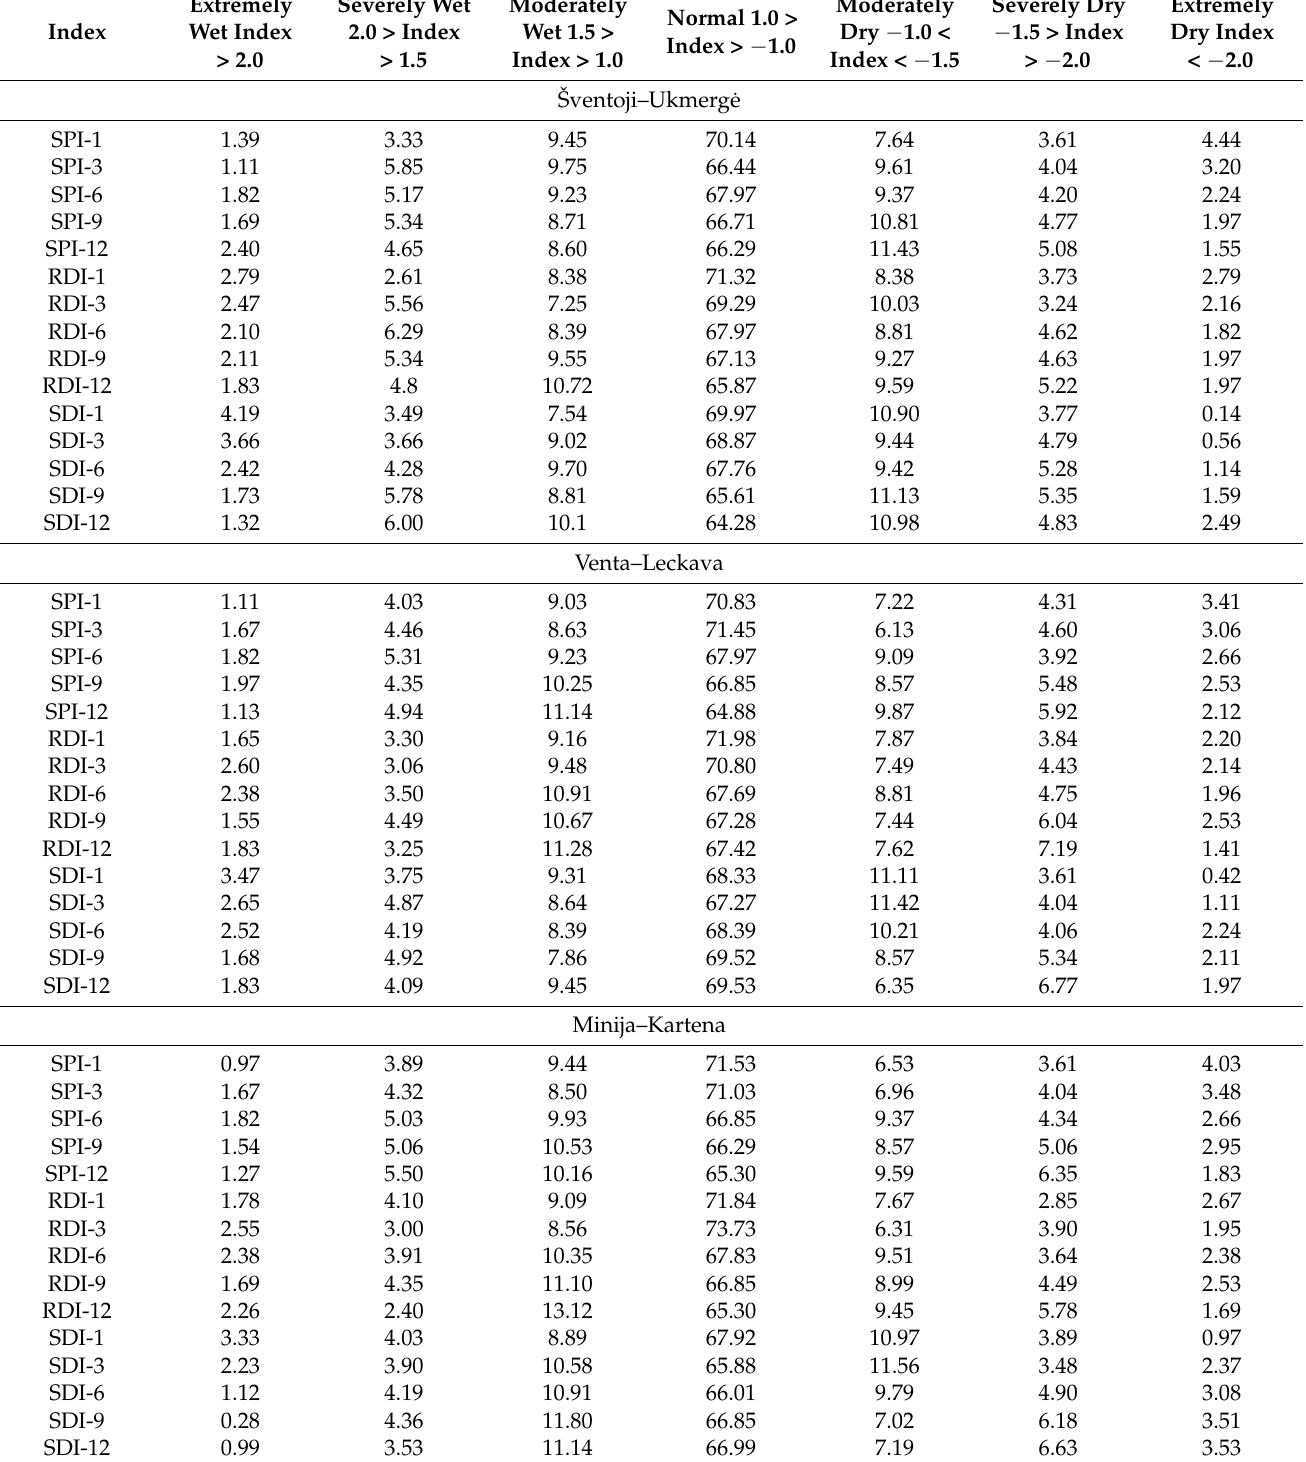
Table 4. Percentage distribution of index values by drought condition